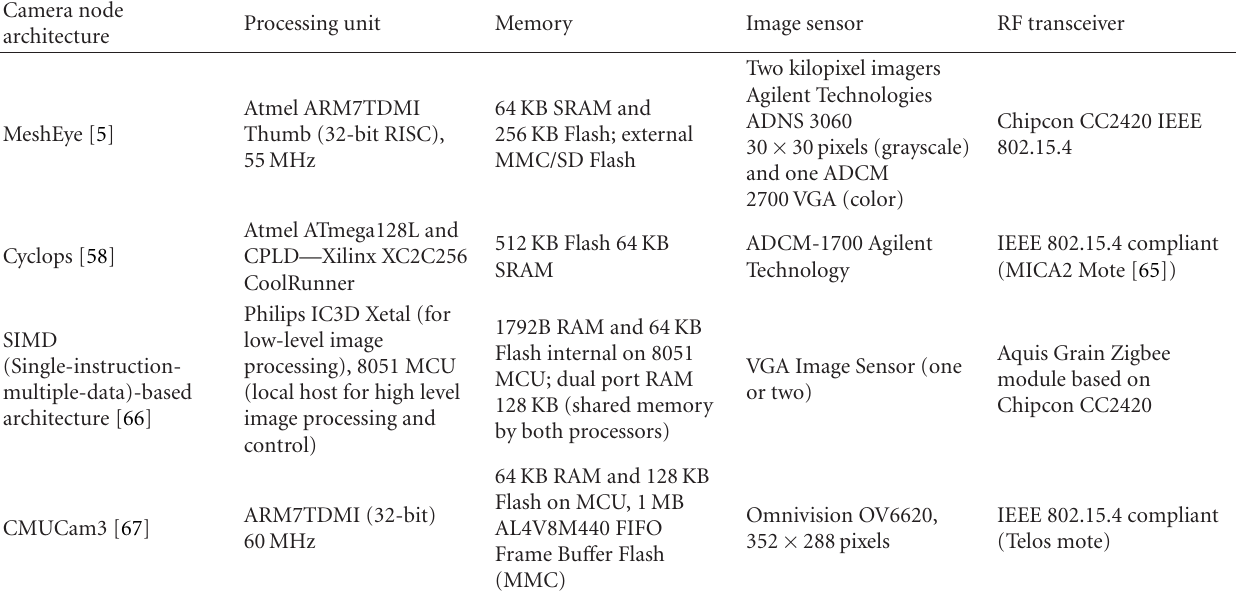
Table 4: Comparison of di ff erent visual sensor node